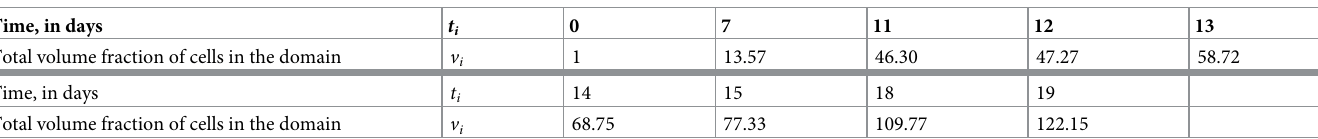
Table 4. Tumor size data set 1. Scaled down from the clinical results in [6]. Time, in